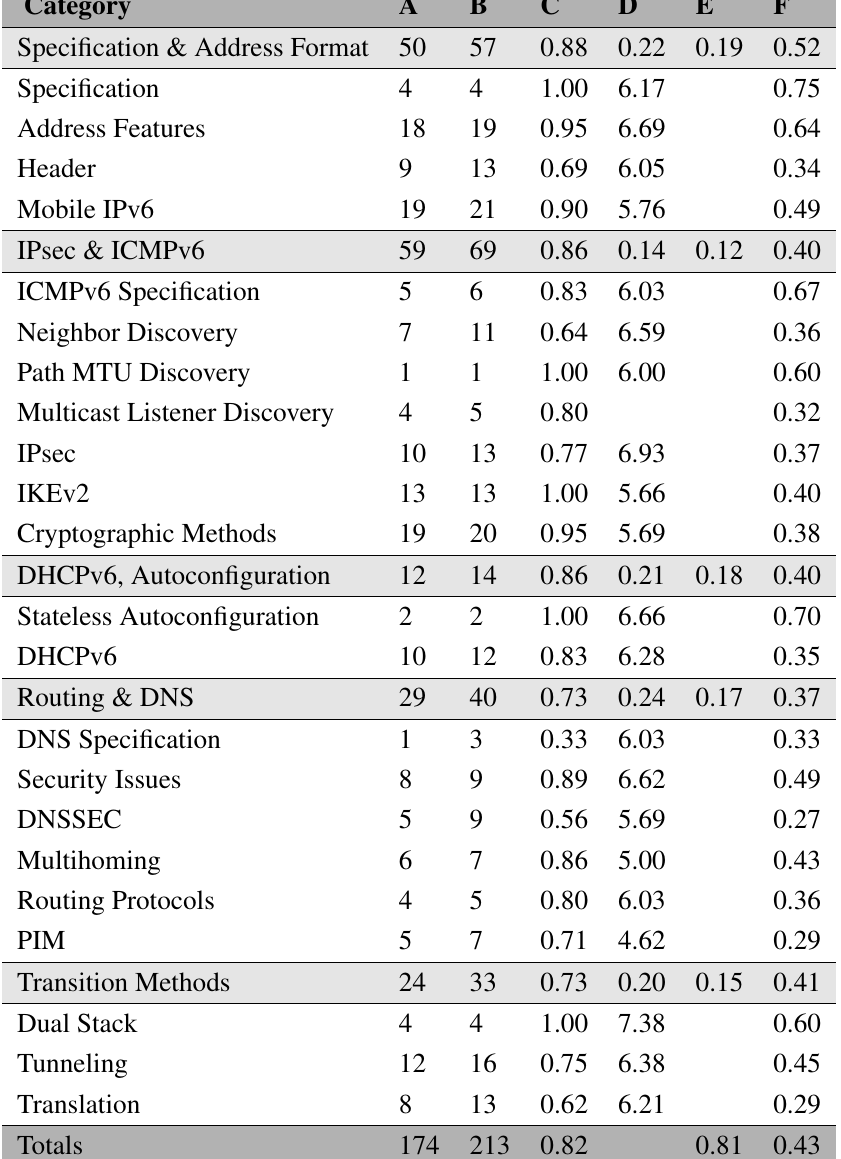
Table 6. NIST Content Completeness and Depth. Columns: A = Count of covered RFCs; B = Count of relevant RFCs; C = Completeness; D = Weight/Importance Rating; E = Weighted Completeness (A * D); F =